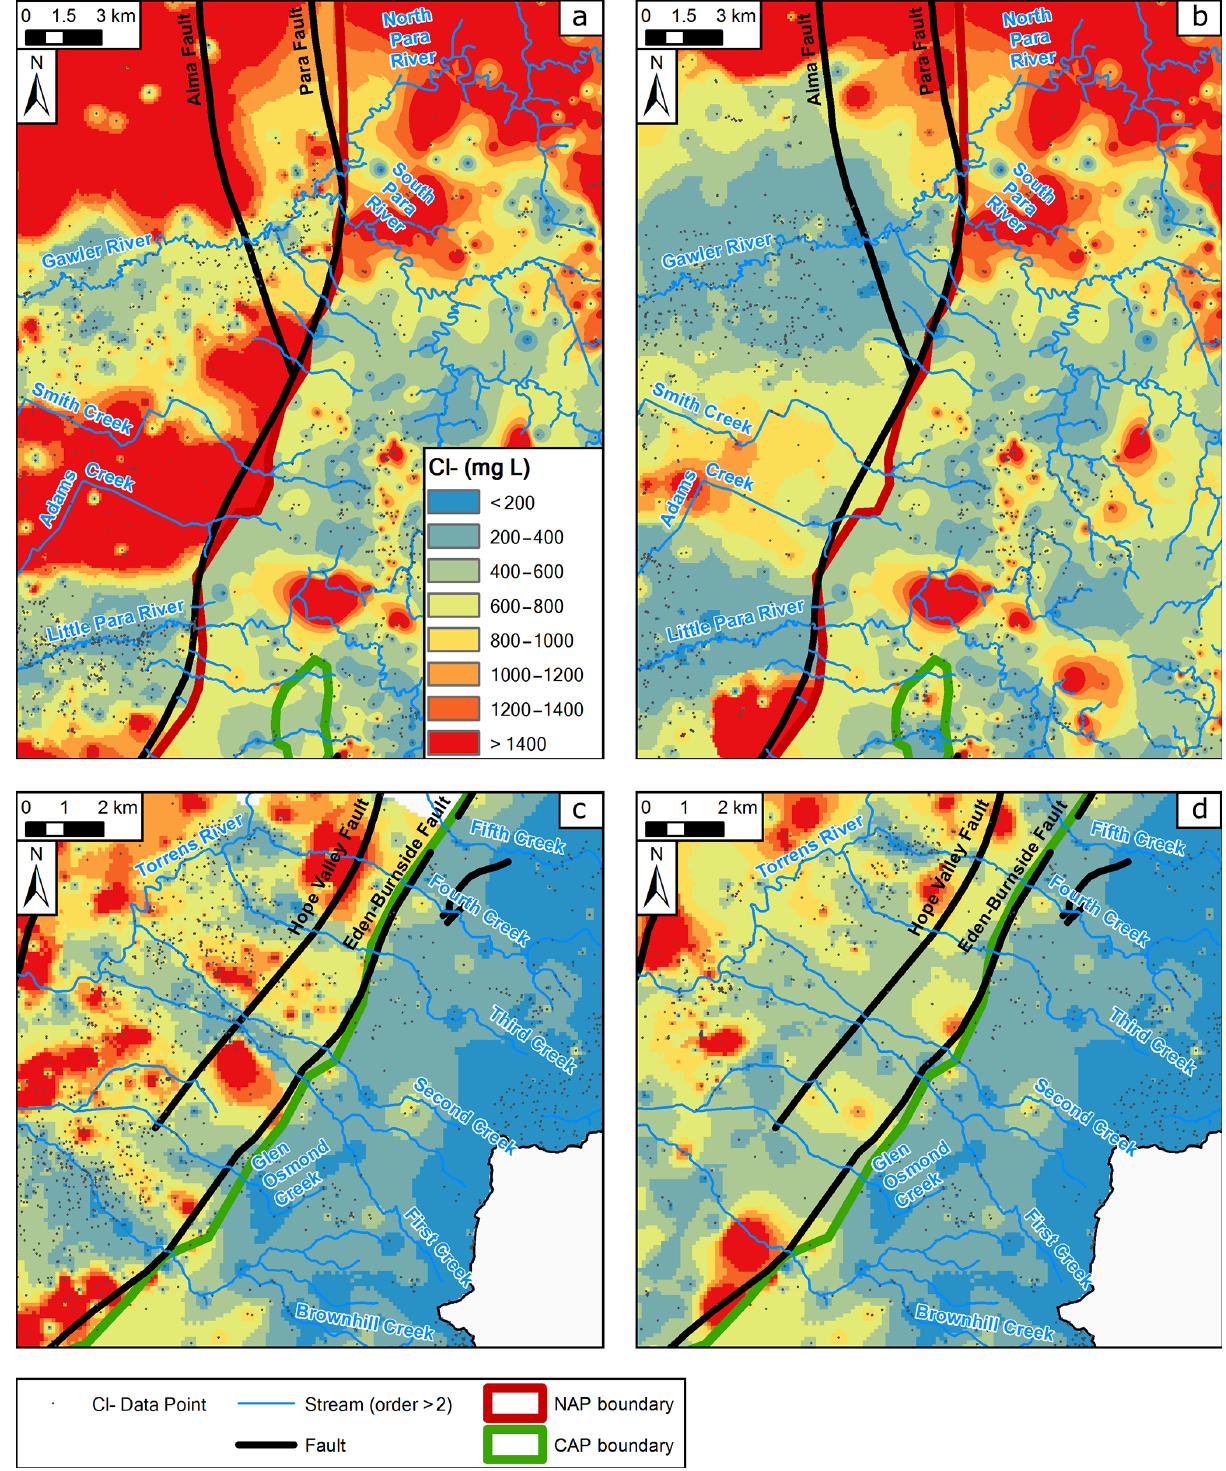
Figure 11. Cl − concentration in the NAP (a–b) and CAP (c–d) focus areas. On the basin side, (a) and (c) show the Cl − concentration in the Quaternary aquifers, while (b) and (d) show the Cl − concentration in the Tertiary aquifers. On the mountain side, all four sub-figures show the Cl − concentration in the Mount Lofty Ranges aquifers. The same colour scheme is applied everywhere and is indicated in (a) . The latter is chosen to be favourable to the study of relatively low-salinity zones; i.e. all Cl − concentrations larger than 1400mgL − 1 are included in the same class (red colour), but in reality much higher values